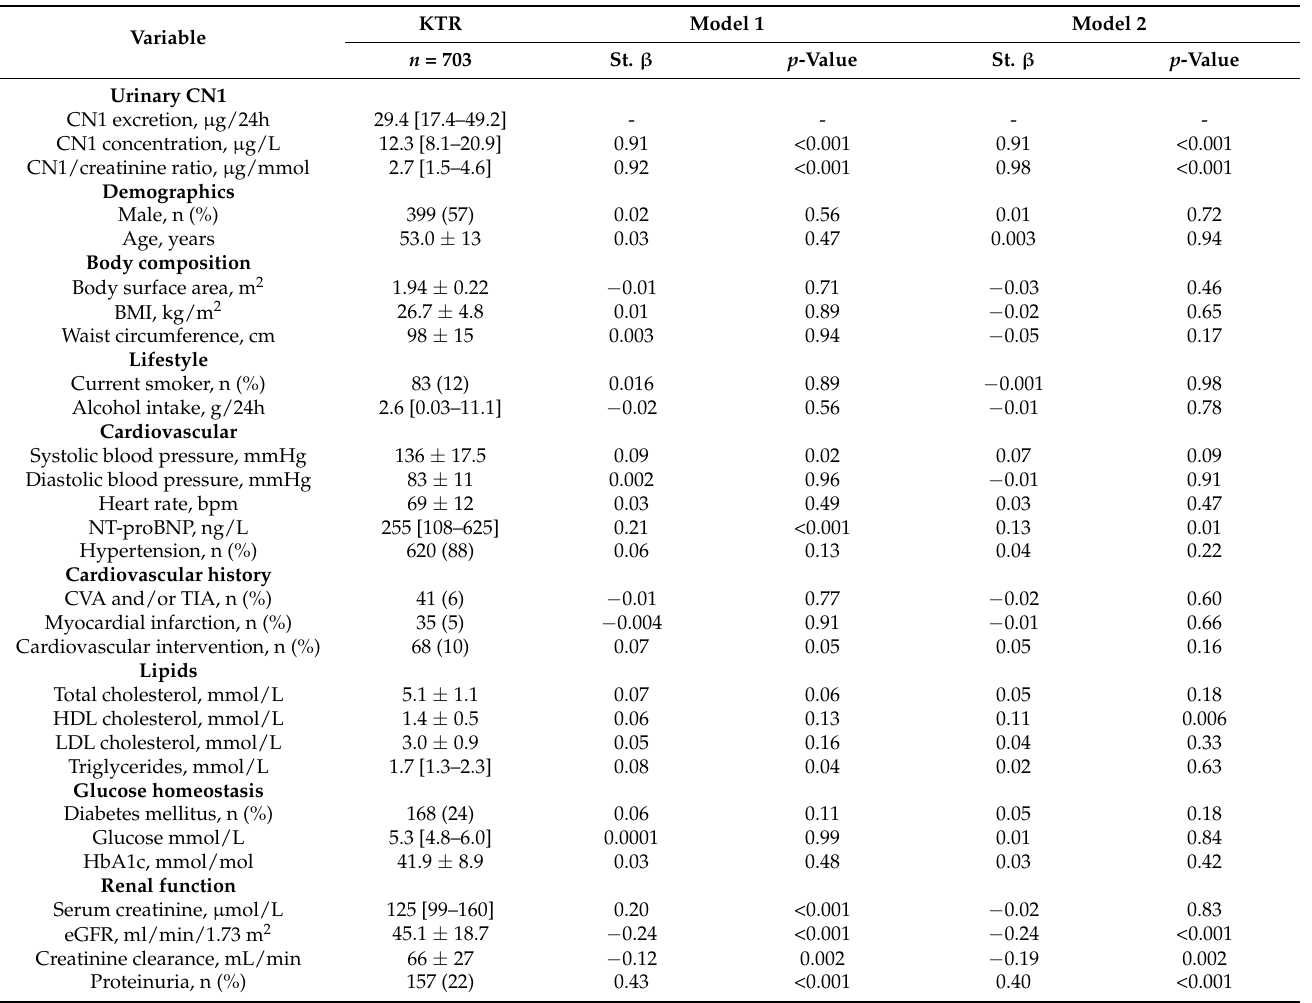
Table 3. Baseline characteristics of KTRs and regression coefficients of the association with urinary CN1 excretions. KTR Model 1 Model Variable